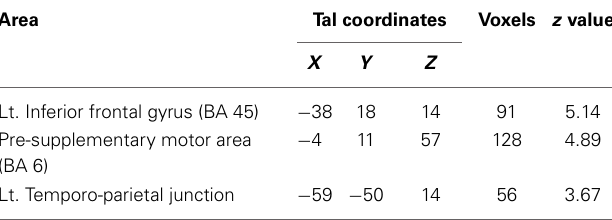
FIGURE 4 | Conjunction analysis showing common activations of intrapersonal and interpersonal emotion regulation, p < 0 . 001, extent threshold 30 voxels. Table 3 | Conjunction analysis showing areas involved in both intrapersonal and interpersonal